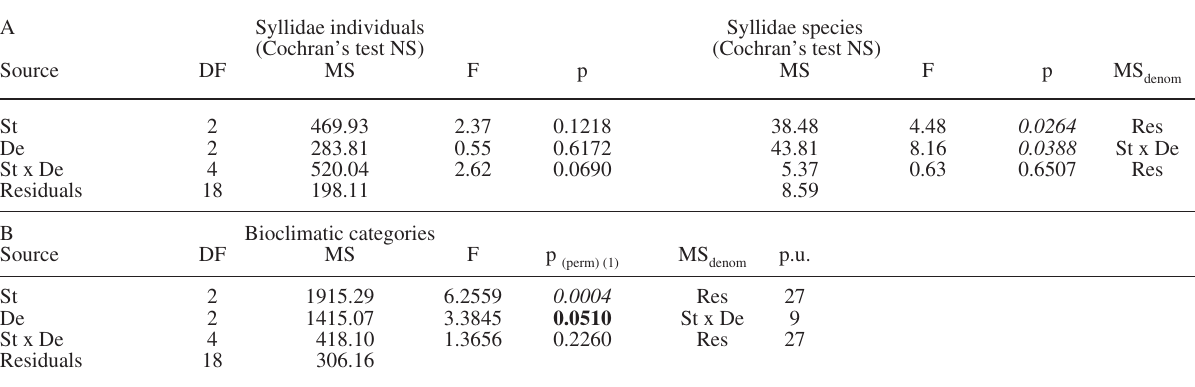
Table 2. – Univariate and multivariate analysis of variance testing differences in the spatial distribution of the syllid assemblages [Factor 1: station (St), three levels, random; Factor 2: depth (De), three levels, orthogonal, fixed; Three replicates]. A, differences in spatial distribu- tion of individuals and species richness (ANOVA, untransformed data). B, differences in spatial distribution of species richness grouped in bioclimatic categories (PERMANOVA based on Bray-Curtis dissimilarity, untransformed data). DF, degrees of freedom; MS, mean square; F, F-ratio; pu, permutable units; MS , denominator mean square. Significant p-values are in italics. denom